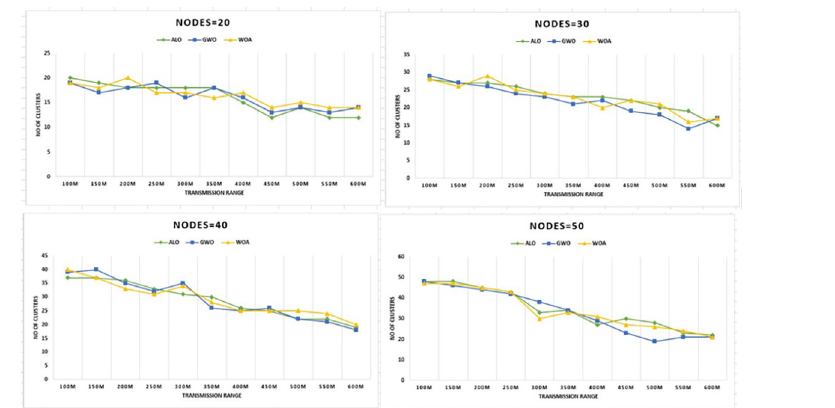
Fig 9. Transmission range versus CHs for nodes 20–50 & grid size 4km x 4km.